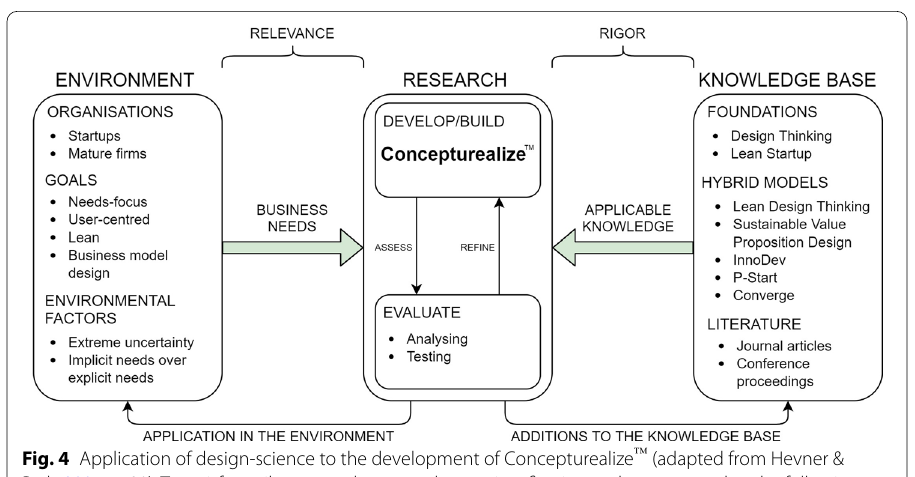
Fig. 4 Application of design-science to the development of Concepturealize ™ (adapted from Hevner & Park, 2004, p. 80). To satisfactorily answer the research question, first it was deconstructed to the following elements: a how can DT principles be combined into LS; b to generate real-needs-focussed; c user-centred; d lean; e business